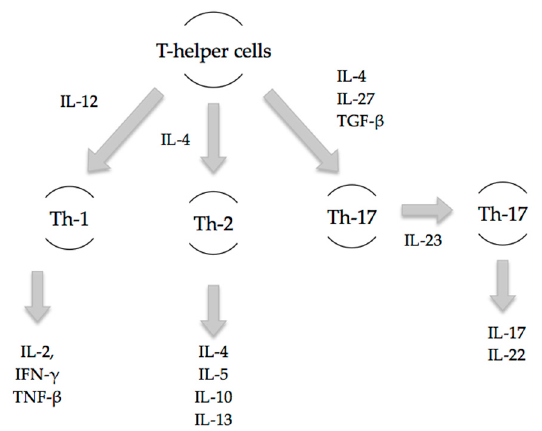
Figure 1. In response to trauma, naïve T-cells differentiate into specific T-cell subsets based on the presence of specific inflammatory mediators. Th-1 cells arise under the influence of IL-12 and provide cell-mediated immunity. Th-2 cells arise under the influence of IL-4 and offer humoral immunity. Th-17 cells arise in the presence of transforming growth factor- β (TGF- β ) and IL-23, and produce pro-inflammatory mediators, IL-17 and IL-22 [6].